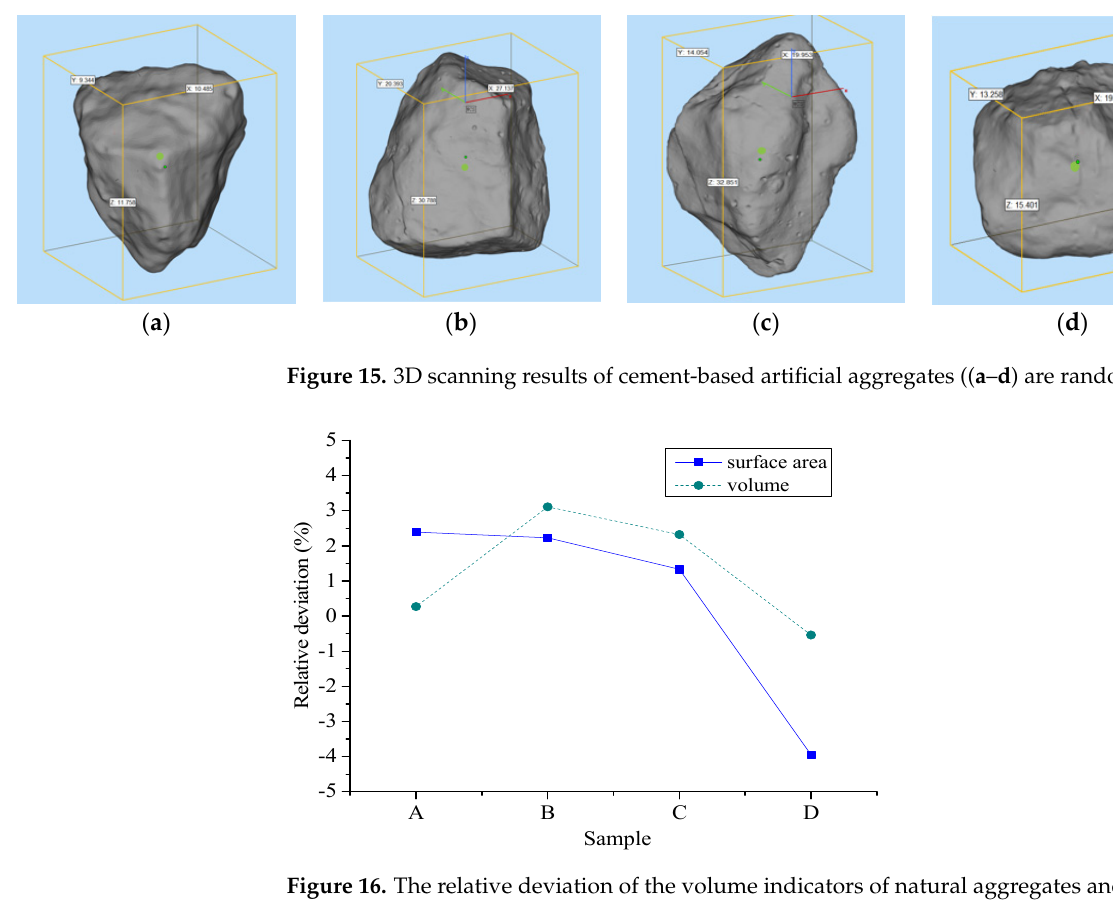
Figure 14. 3D scanning results of natural aggregates ( a – d are random samples).